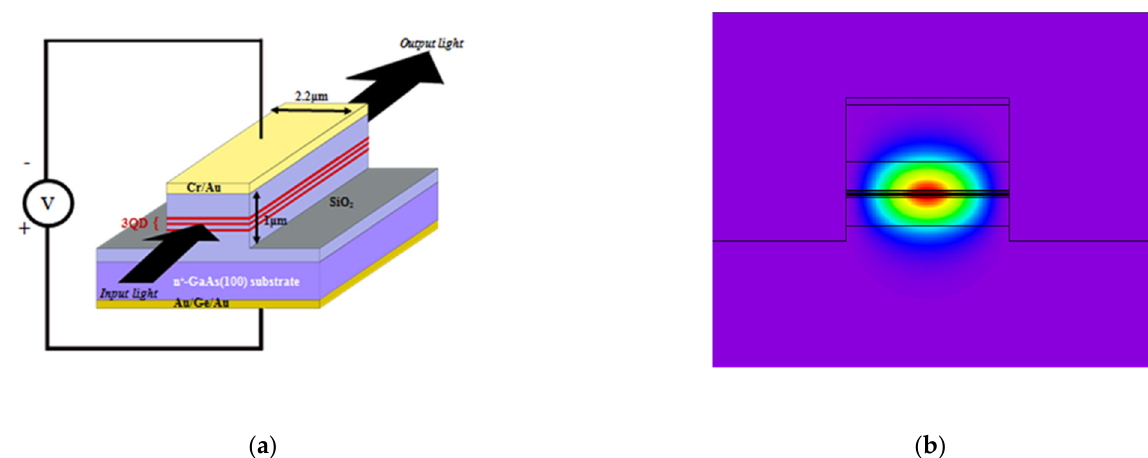
Figure 5. ( a ) Schematic diagram of EO measurement, and ( b ) TE mode profile at = 1515 nm for the single-mode ridge waveguide based on triple-layer In 0.75 Ga 0.25 As QDs ( d = 5 nm).